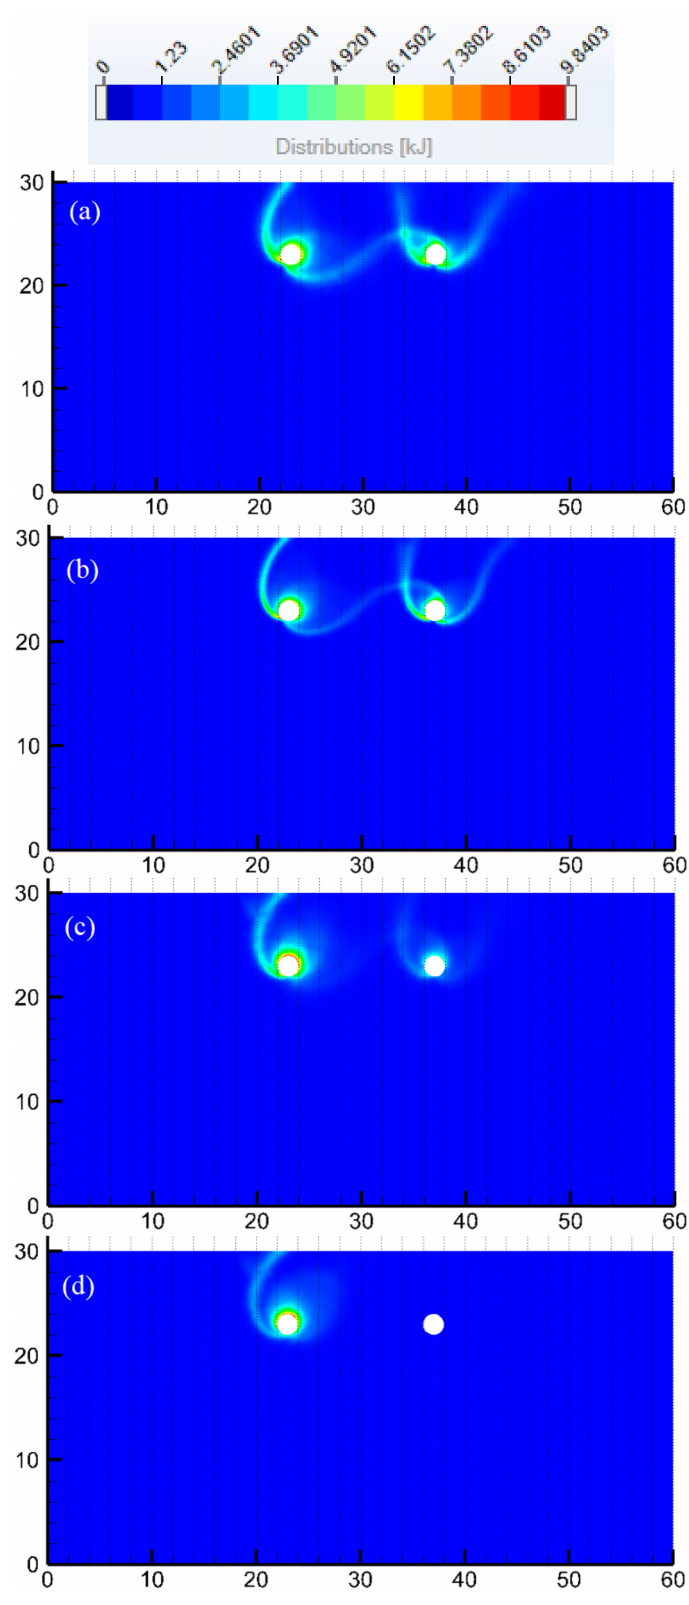
Figure 12. Upper bound failure mechanisms with S / D = 7, H / D = 3, γ D / c = 1 and k h = 0.1 for ( a ) ϕ = 5 ◦ ; ( b ) ϕ = 10 ◦ ; ( c ) ϕ = 15 ◦ ; and ( d ) ϕ = 20 ◦